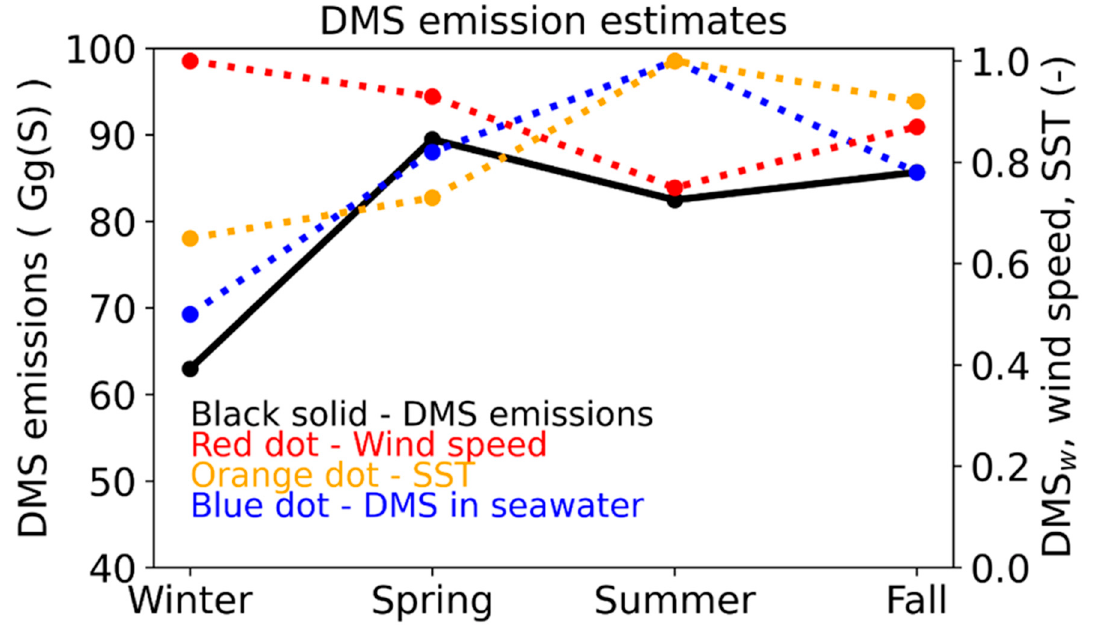
Figure 1. Seasonal DMS emissions over the modeling domain calculated using the Liss and Merlivat [47] parameterization for the water side gas transfer velocity (k w ). DMS w , wind speed, and SST values shown on the right y-axis are dimensionless. Normalized values were calculated by dividing the actual values by their maximum values. Winter represents December–February, spring represents March–May, summer represents June–August, and fall represents September–November.